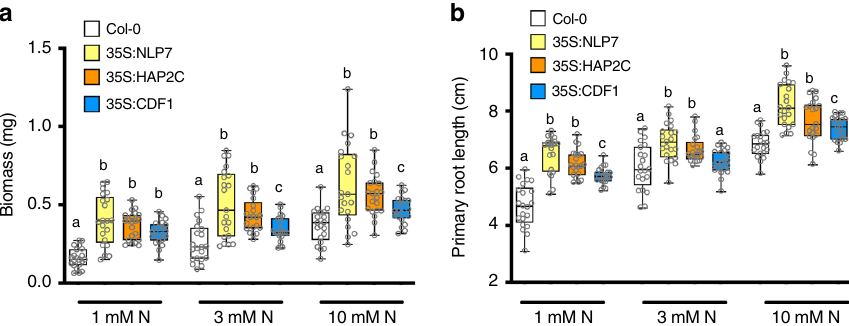
Fig. 5 Overexpressing early and transient TF targets of NLP7, HAP2C, and CDF1 signi fi cantly increases plant biomass and primary root growth. Col-0, 35S:NLP7, 35S:HAP2C, and 35S:CDF1 plants were grown for 2 weeks on vertical plates containing different concentrations of N. a Plant growth of NLP7 , HAP2C , and CDF1 overexpressor lines is enhanced as compared with wild-type Col-0 plants under increasing N concentrations. b Primary root growth of NLP7 , HAPC , and CDF1 overexpressor lines is enhanced as compared with wild-type plants under increasing N concentrations. Data are from three independent experiments ( n = 21). Different letters indicate mean values differ signi fi cantly between genotypes in each condition ( t test, p -value < 0.05). Source data are provided as a Source Data fi le.